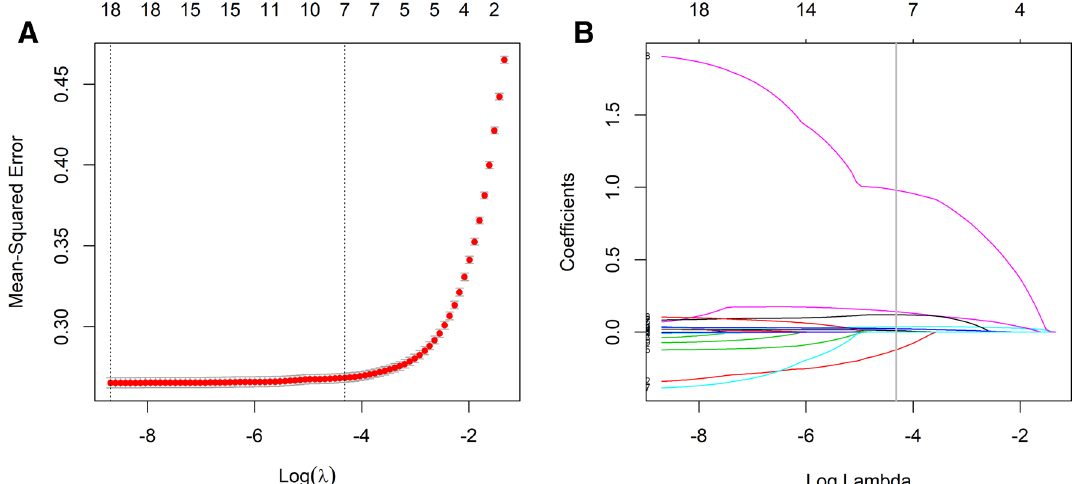
Figure 2. Variable selection by the LASSO binary logistic regression model. ( A ) Optimization parameters (lambda) of the LASSO model were selected using tenfold cross-validation. The mean-squared error was plotted versus log (lambda). ( B ) LASSO coefficient profiles of the 18